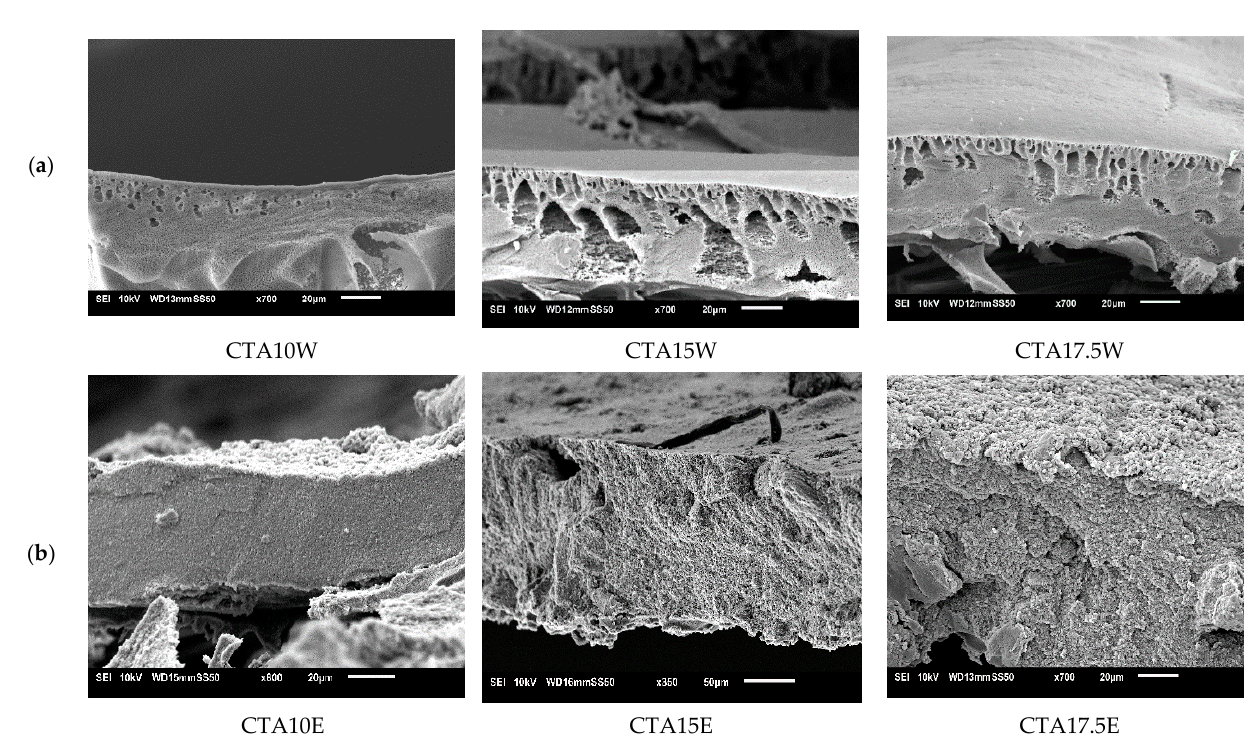
Figure 6. Influence of cellulose triacetate (CTA) concentration on membrane performance in terms of RB rejection and permeance. Striped lines represent membranes prepared using ethanol as non- solvent and full lines those with water as non-solvent.